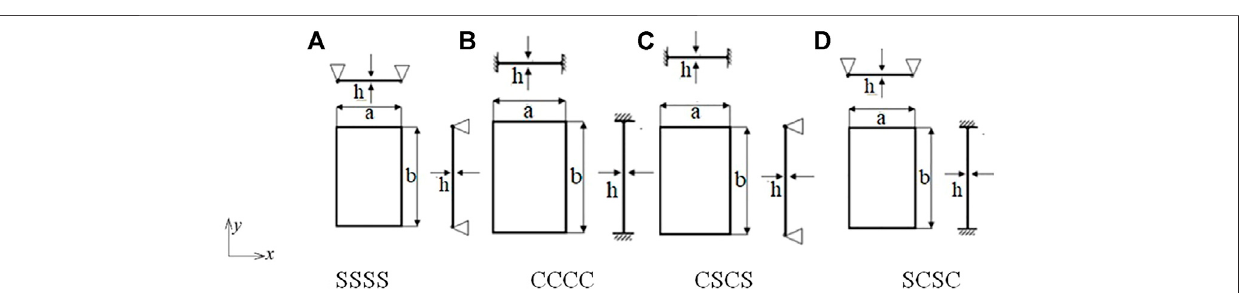
FIGURE 9 | Periodic unit (rectangular plate, a/b = 0.5) with different edge boundary conditions (A) SSSS, (B) CCCC, (C) CSCS, and (D) SCSC.